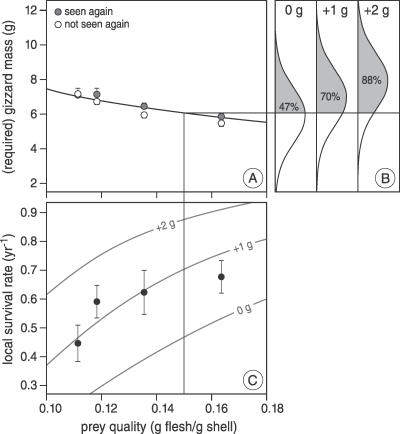
Quantitative Relations between Prey Quality, Gizzard Mass, and Local Survival Rate(A) Gizzard mass required to maintain energy balance declines as a function of prey quality (solid line). Gizzards of birds seen again after catching fit this relationship (gray dots; mean ± SE), whereas gizzards of birds not seen again are significantly smaller (open dots; note that both groups almost entirely overlap in the poorest-quality year).(B) Observed gizzard masses upon arrival are distributed according to the left-most normal distribution. If there were no room for flexibly adjusting gizzard mass (0 g), only 47% of the arriving knots would be able to avoid starvation (shaded area) at an example prey quality of 0.15 g flesh per g shell (dashed line). If there were room for flexibility (+1 and +2 g in this example), a much larger proportion would be able to survive (respectively 70% and 88%).(C) Observed local survival rate (y−1; ± SE) increased as a function of prey quality and best matched with predicted survival in a +1-g flexibility scenario.